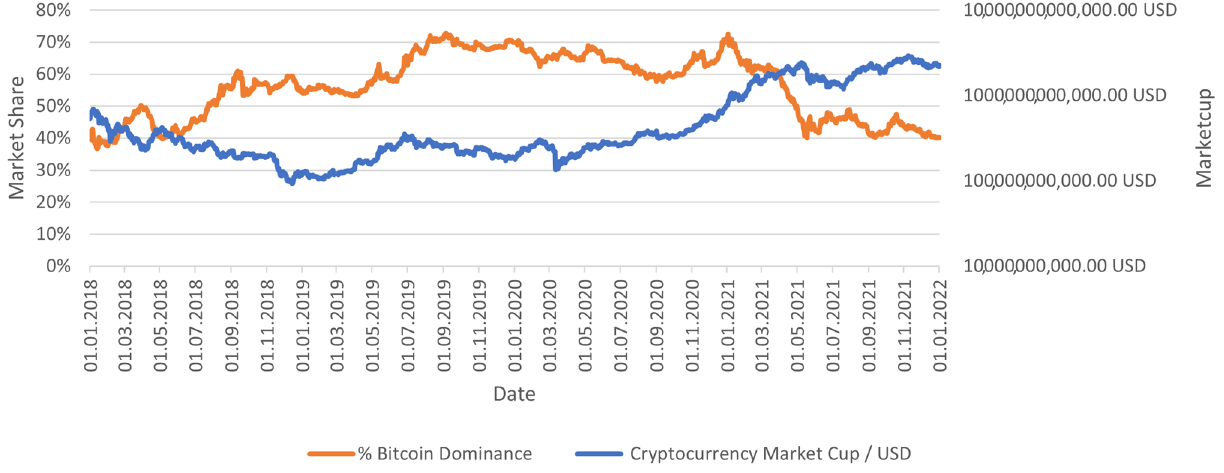
Figure 4. Cryptocurrency total market cup and Bitcoin dominance in the period under study.